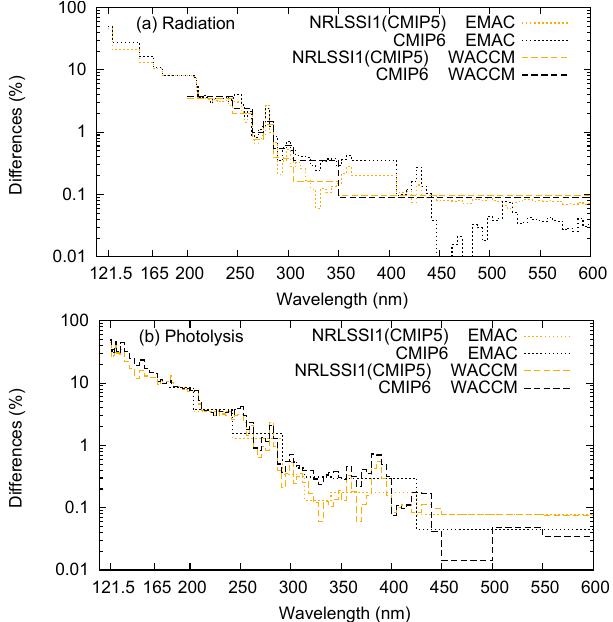
Figure 9. SSI differences in percent for the solar amplitude be- tween perpetual solar-maximum and perpetual solar-minimum con- ditions. (a) in the spectral resolution of the radiation schemes; (b) in the spectral resolution of the photolysis schemes of EMAC (short- dashed) and CESM1(WACCM) (long-dashed).